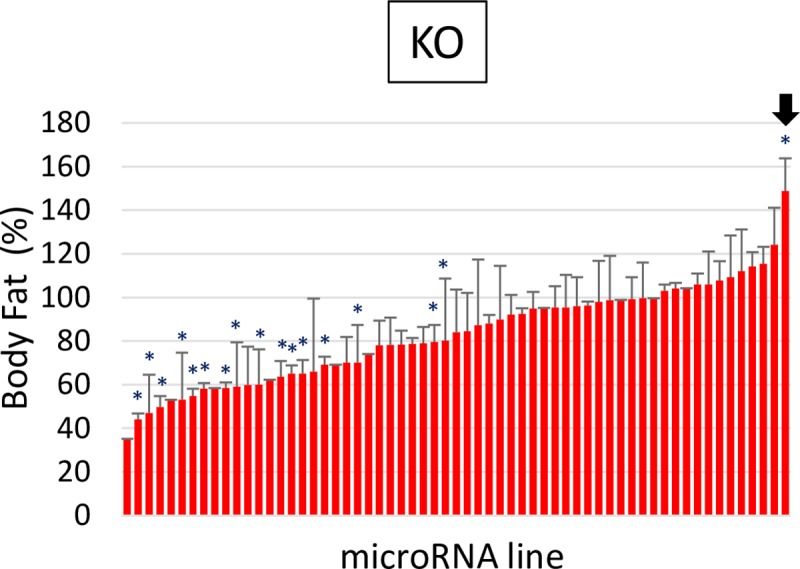
Loss-of-function miRNA heterozygotes altered body fat.MiRNA knock-out (KO) lines were mated with the Act5C-Gal4 driver. The resulting F1 heterozygotes were comparatively analyzed against control flies that were generated from the cross between W1118 and the same Act5C-Gal4 driver. The relative body fat of each miRNA line was calculated by normalizing each heterozygote’s triglyceride (TG) to the control TG. Relative Body Fat (%) = (TGmiRNA/TGcontrol) X 100, *: P < 0.01 by Student’s t-test. The black arrow shows miR-969.